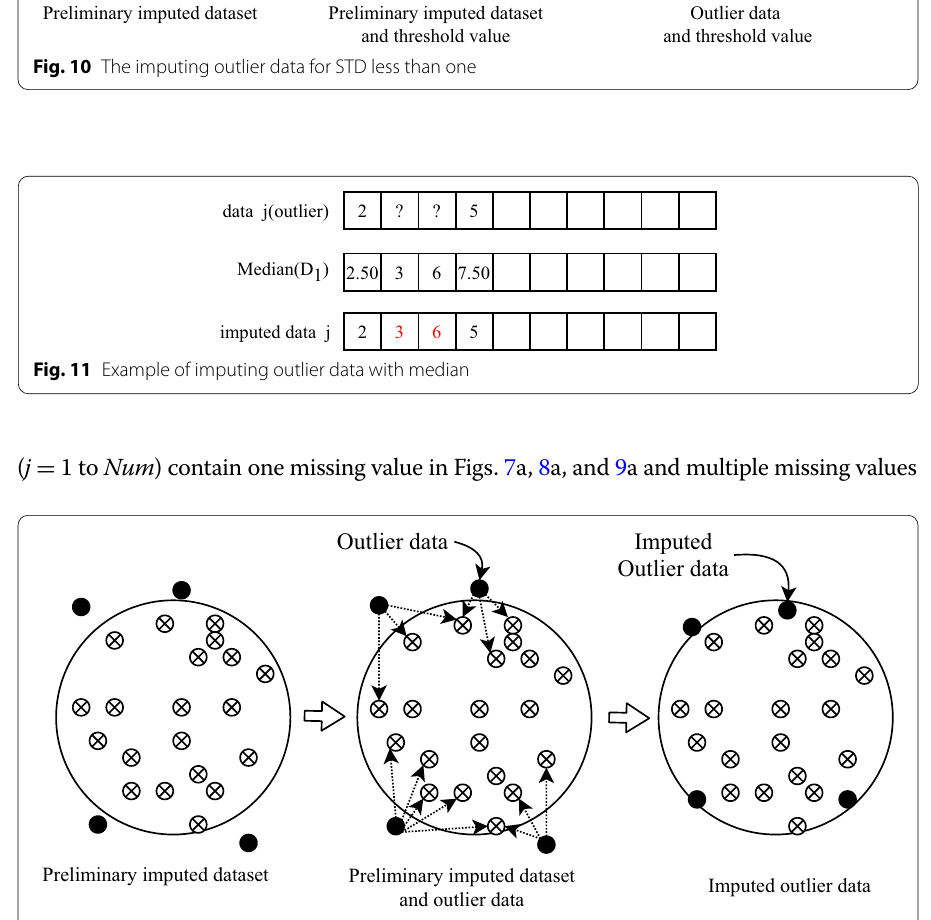
Fig. 12 Imputing outlier data for STD greater than or equal to